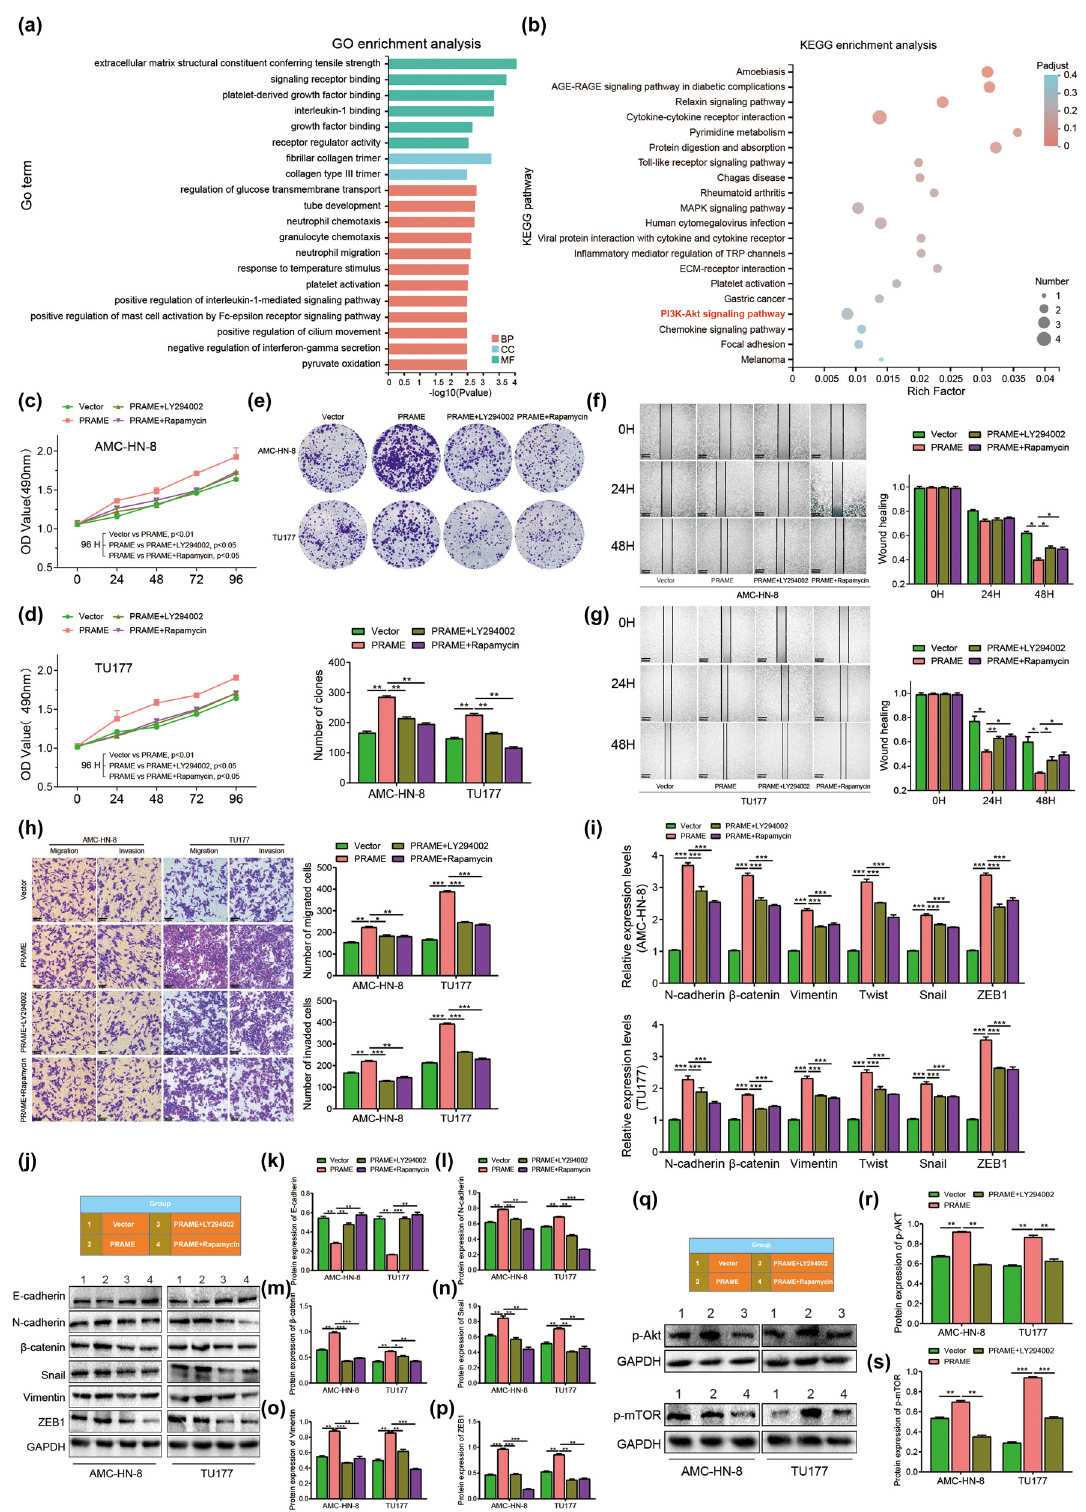
Figure 5: PRAME promotes the progression of LSCC via the PI3K/AKT/mTOR signaling pathway. ( a ) The relevant biological function of PRAME through the GO enrichment analyses. ( b ) The expression of PRAME showed strong correlation with PI3K/AKT/mTOR signaling pathway through the KEGG enrichment analyses. ( c – e ) The inhibitor ( LY294002 or Rapamycin ) partially abrogated PRAME overexpression - induced cell prolif - eration in vitro . ( f – h ) The inhibitor ( LY294002 or Rapamycin ) partially abrogated PRAME overexpression - induced cell migration and invasion in vitro . ( i ) The inhibitor ( LY294002 or Rapamycin ) abrogated PRAME overexpression - induced mRNA expression levels of EMT markers. ( j – p ) The inhibitor ( LY294002 or Rapamycin ) abrogated PRAME overexpression - induced protein expression levels of EMT markers. ( q – s ) LY294002 or Rapamycin reversed the protein expressions of p - AKT and p - mTOR mediated by PRAME ( * P < 0.05, ** P < 0.01, *** P < 0.001 )